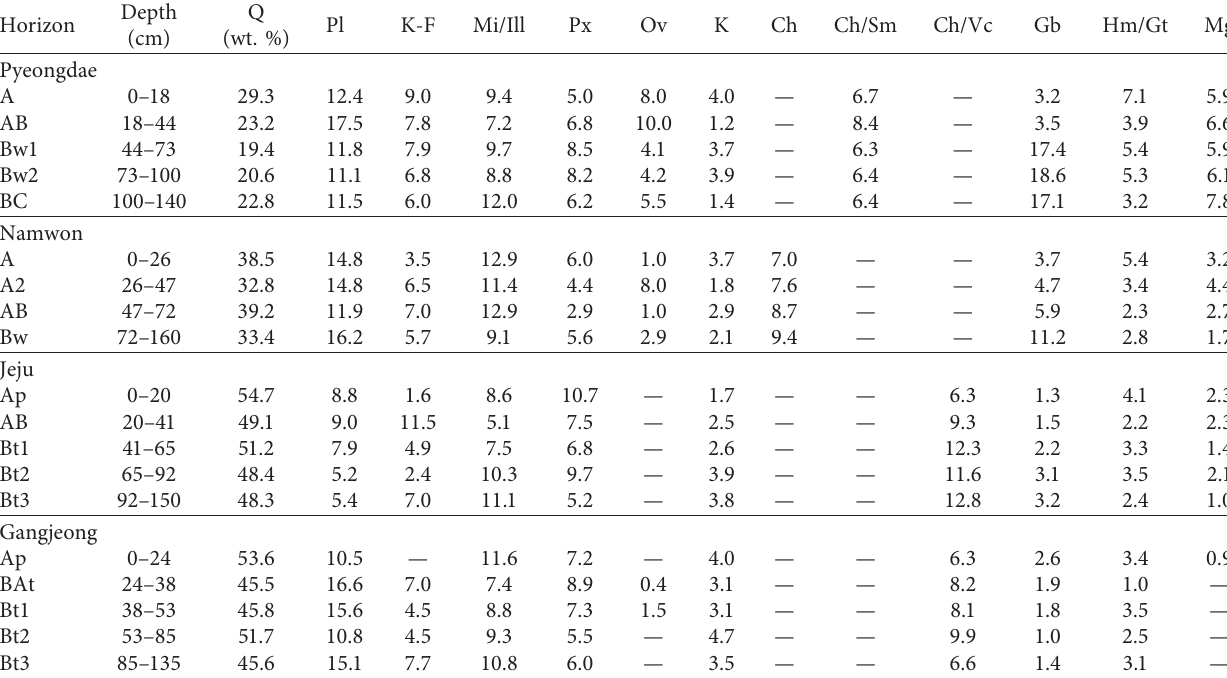
Table 4: Mineral compositions of soil